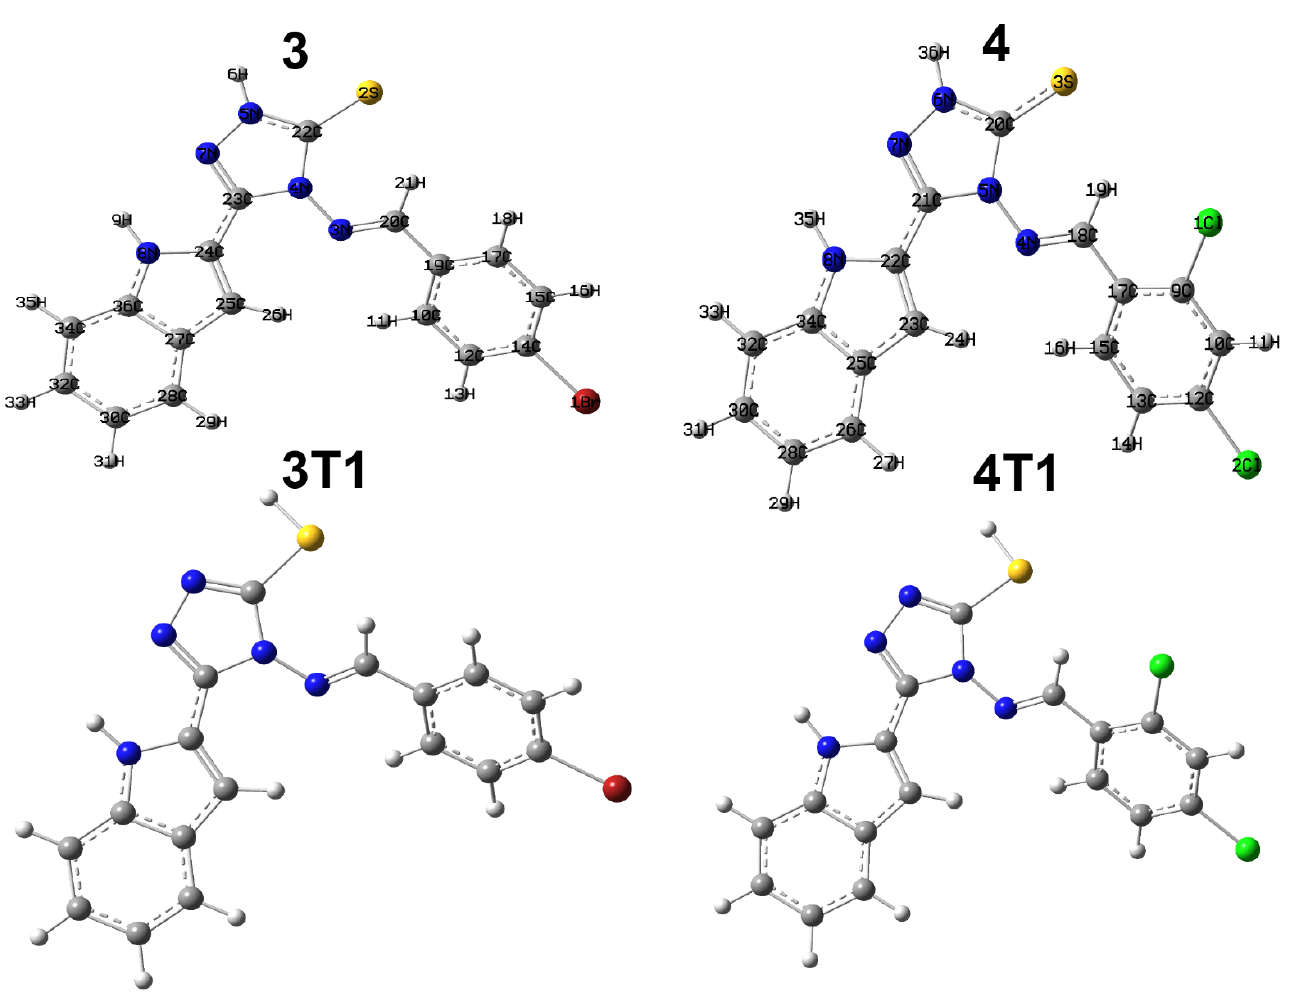
Crystals 2021 , 11 , x FOR PEER REVIEW Figure 10. The optimized structures of the thione ( upper ) and thiol ( lower ) tautomers of the studied systems.